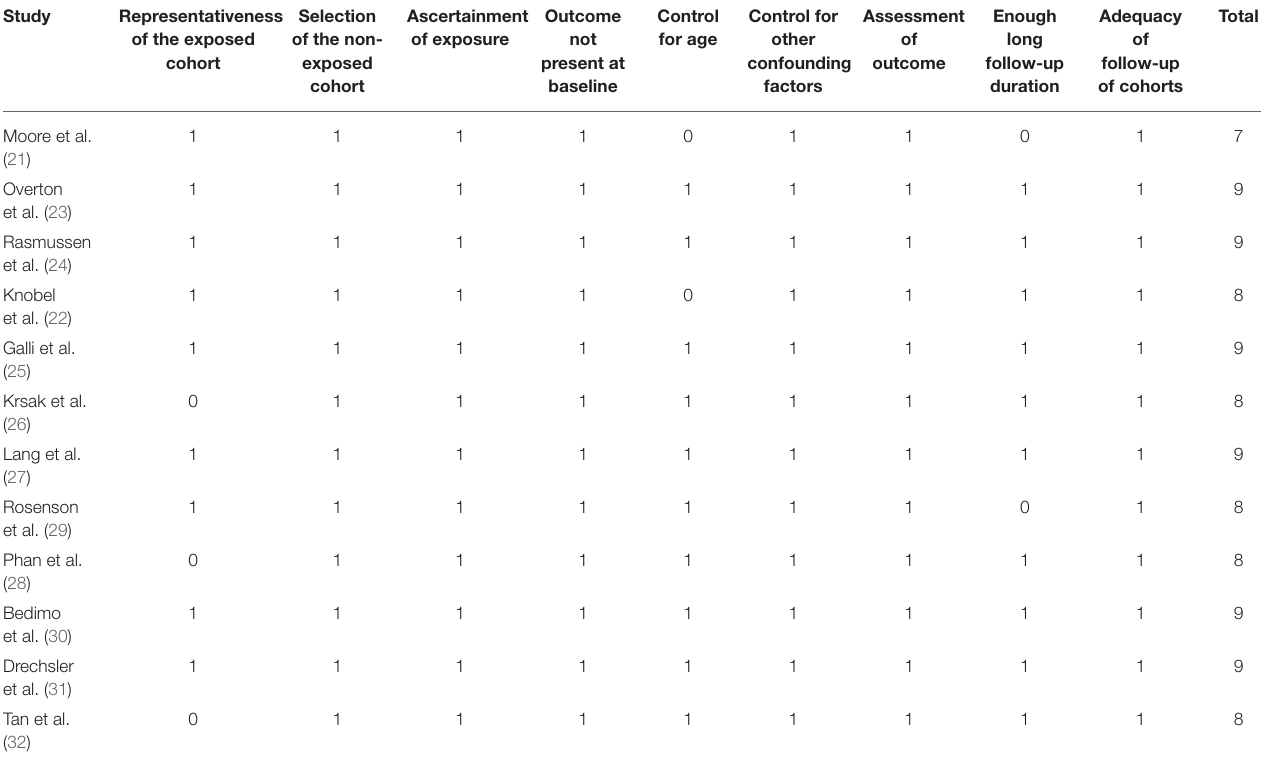
TABLE 2 | Details of study quality evaluation via the Newcastle–Ottawa Scale. Study Representativeness